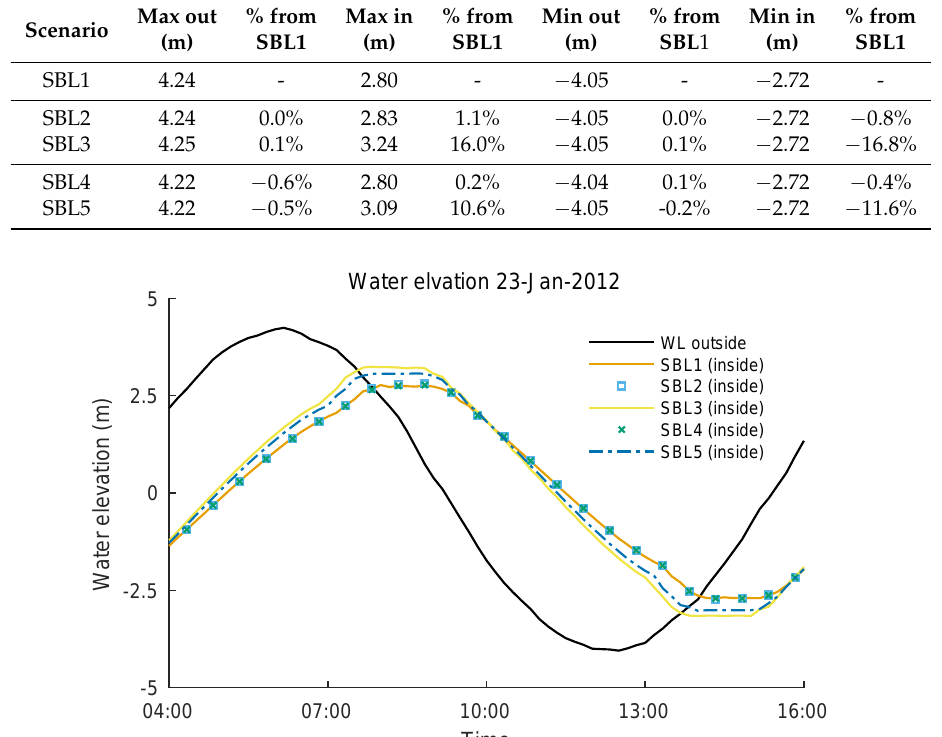
Table 4. Maximum and minimum water level values in meters recorded during a spring tide.